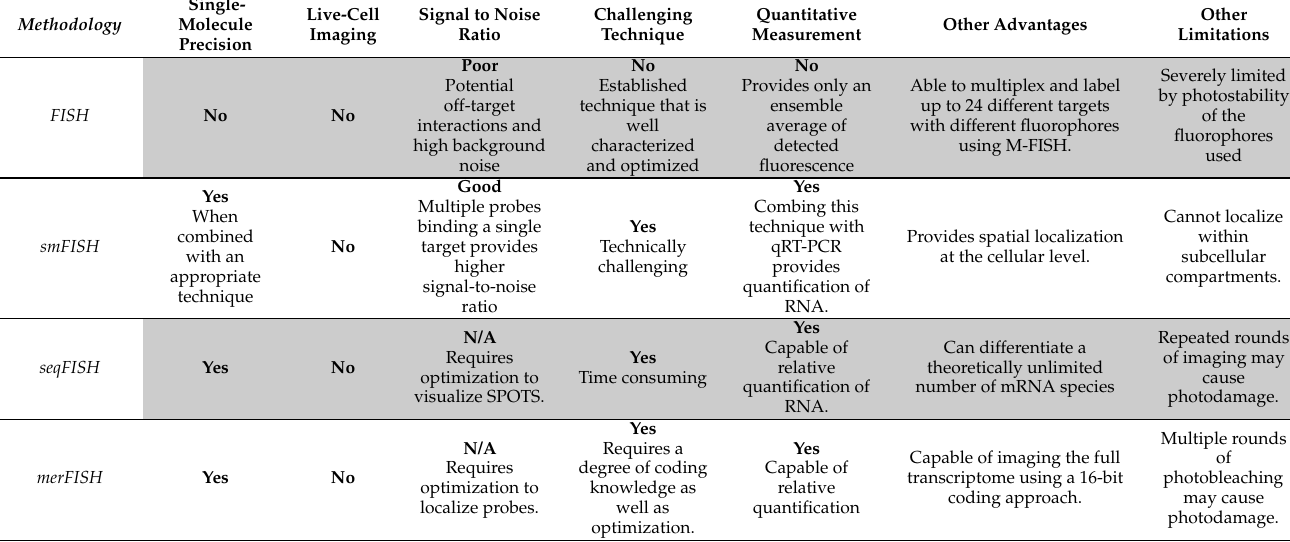
Table 1. A Non-exhaustive Summary of the Advantages and Disadvantages of techniques and labeling strategies. This table provides a brief summation of key advantages and disadvantages of key techniques and labeling strategies discussed in this